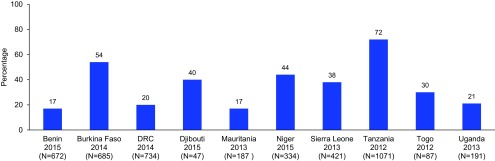
Percentage of Facilities Providing Family Planning Services With All Tracer ItemsaAbbreviation: DRC, the Democratic Republic of the Congo.a Tracer items include availability of guidelines for family planning, staff trained in family planning services, blood pressure apparatus, combined oral contraceptive pills, injectable contraceptives, and male condoms on the day of facility assessment.